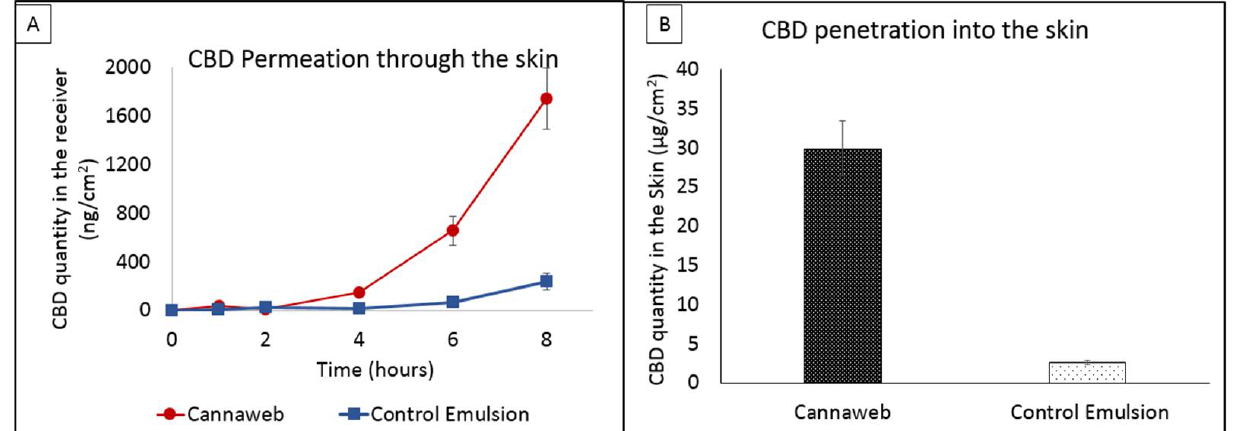
Figure 6. In vitro profiles of CBD ( A ) permeation across the skin ( B ) penetration into the skin fol- lowing application from F16 (Cannaweb system) vs. Control emulsion containing an equal CBD amount. n = 4, Mean ± SD, p < 0.01 considered very significant by unpaired t-test. The CBD amount extracted from the skin at the end of the experiment was 29.9 ± 5.5 µg/cm 2 from Cannaweb comapred to 2.6 ± 0.5 µg/cm 2 for the control system.